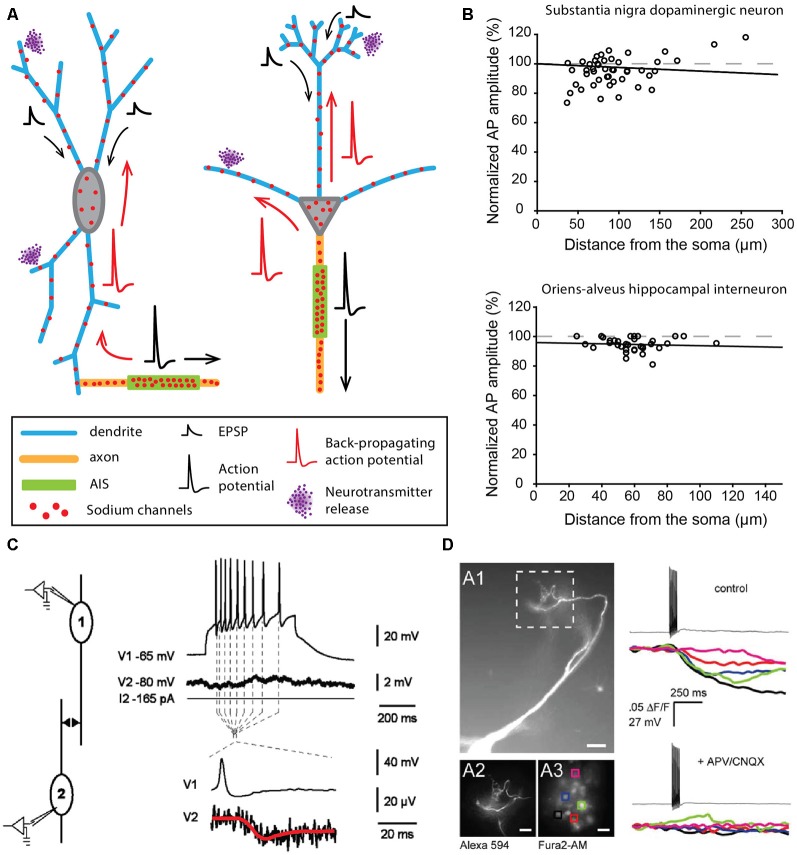
Neurons faithfully back-propagating APs and releasing neurotransmitters from their dendrites. (A) Schematics corresponding to a dopaminergic neuron of the substantia nigra pars compacta (left) and a mitral cell of the olfactory bulb (right). (B) AP back-propagation in substantia nigra dopaminergic neurons (top) and oriens-alveus interneurons (bottom). (C) Dendritic release of dopamine from substantia nigra dopaminergic neurons measured in paired recordings of dopaminergic neurons. The post-synaptic neuron shows a substantial hyperpolarization (red trace) in response to APs in the pre-synaptic neuron. (D) Dendritic release of glutamate from mitral cells of the olfactory bulb measured by calcium fluorescence in the post-synaptic cells. Mitral cells were filled with Alexa 594 (A1 panel), and regions of interest (ROI) on post-synaptic periglomerular cells (A3) were used to measure post-synaptic responses around the apical tuft of the mitral cell (12). Calcium transients were measured in all ROIs after spiking of the mitral cell (top right) and were blocked by antagonists of glutamate receptors (bottom right). (B) Top, adapted from Gentet and Williams (2007) © 2007 Society for Neuroscience; bottom, adapted from Martina et al. (2000), with permission. (C) Reproduced from Vandecasteele et al. (2008) © 2008 National Academy of Sciences. (D) Reproduced from Castro and Urban (2009) © 2009 Society for Neuroscience.